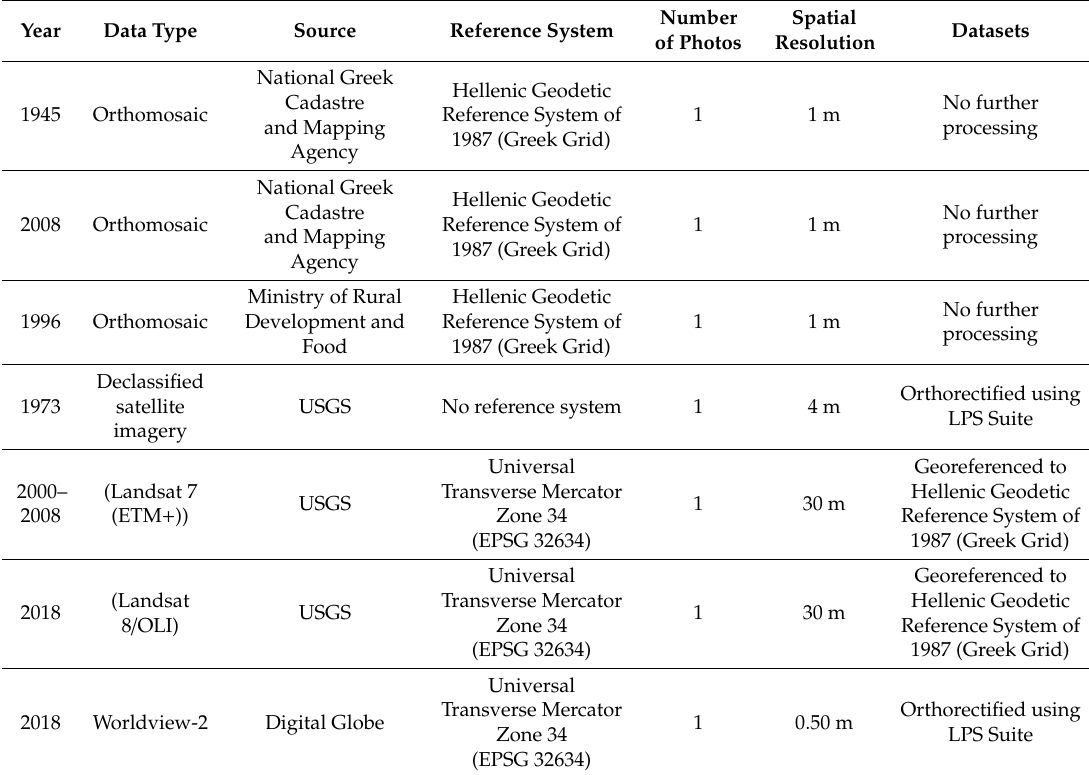
Table 1. Datasets used in the current